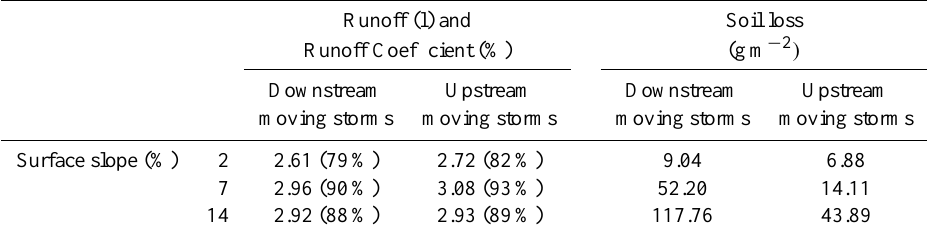
Fig. 2. Runoff hydrographs (top) and respective sediment graphs (bottom) for different surface gradients (2%, 7% and 14%), for downstream and upstream moving rainstorms. Each graph represents mean values from 4 experimental runs. Table 1. Total measured runoff volumes (l), Runoff Coefficients, and total measured soil losses (gm − 2 ) as a function of surface slope and direction of rainstorm movement, for all the experimental